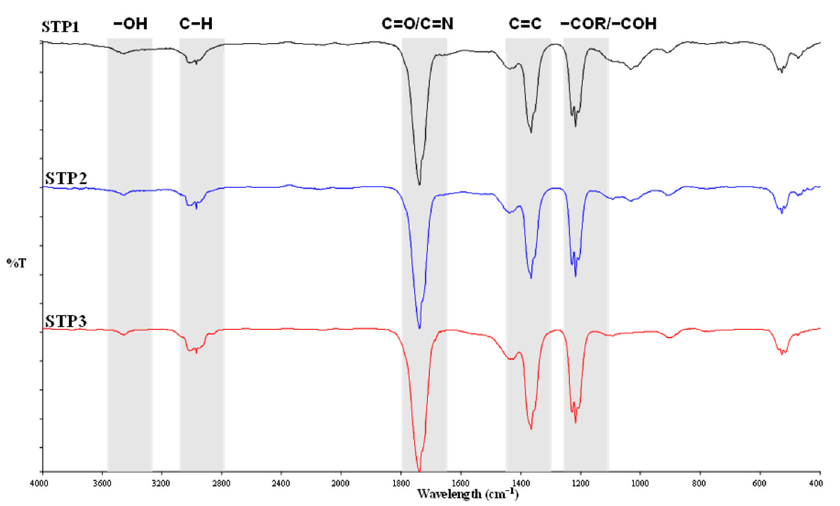
Figure 2. FTIR spectra of raw, dewatered sewage sludge samples.